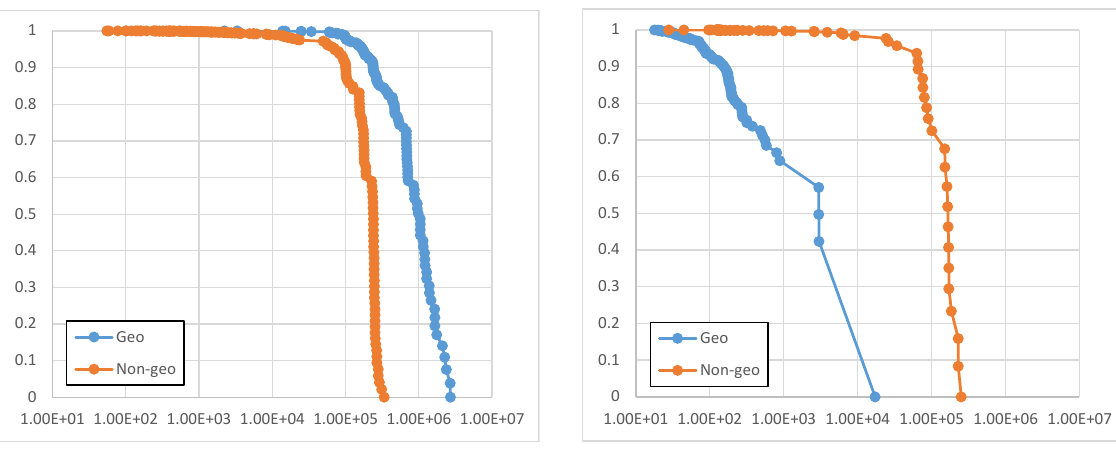
Figure 10. CCDF of acceptance ( a ) and completion ( b ) time (in seconds) for geo-notified and non-geo notified